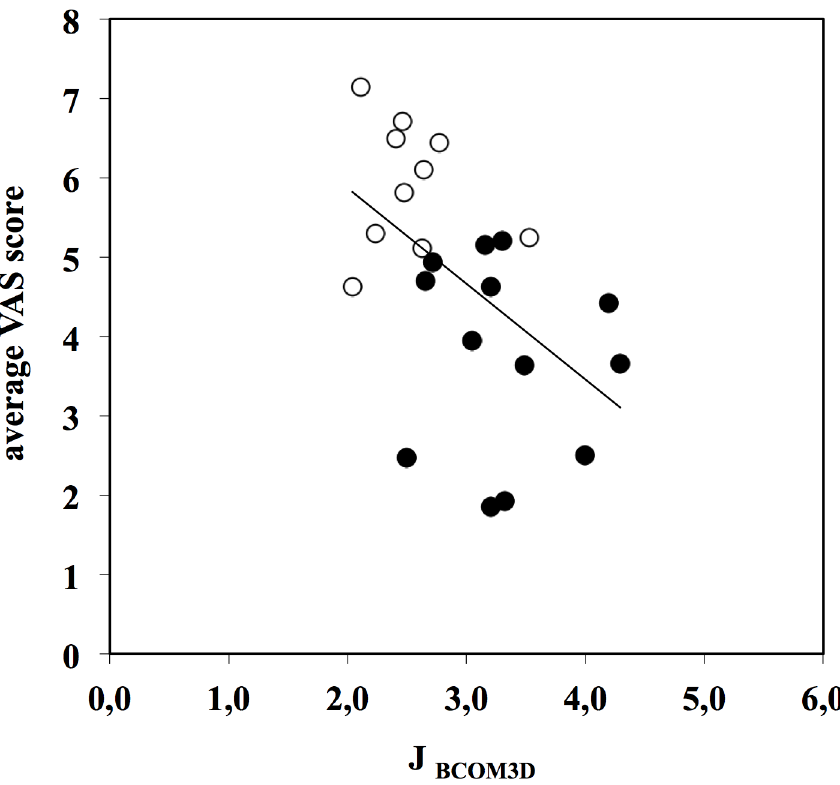
Fig 4. Relationship between VAS score and jerk of BCOM (j BCOM3D ). VAS score = 8.28 – 1.21 (cid:1) j BCOM3D ( R = 0.511, N = 25, p < 0.05). Data points are the grand averages of the scores given by both expert and non- expert observers for the four investigated movement characteristics (open dots: high-level performance, full dots: middle-level performance).